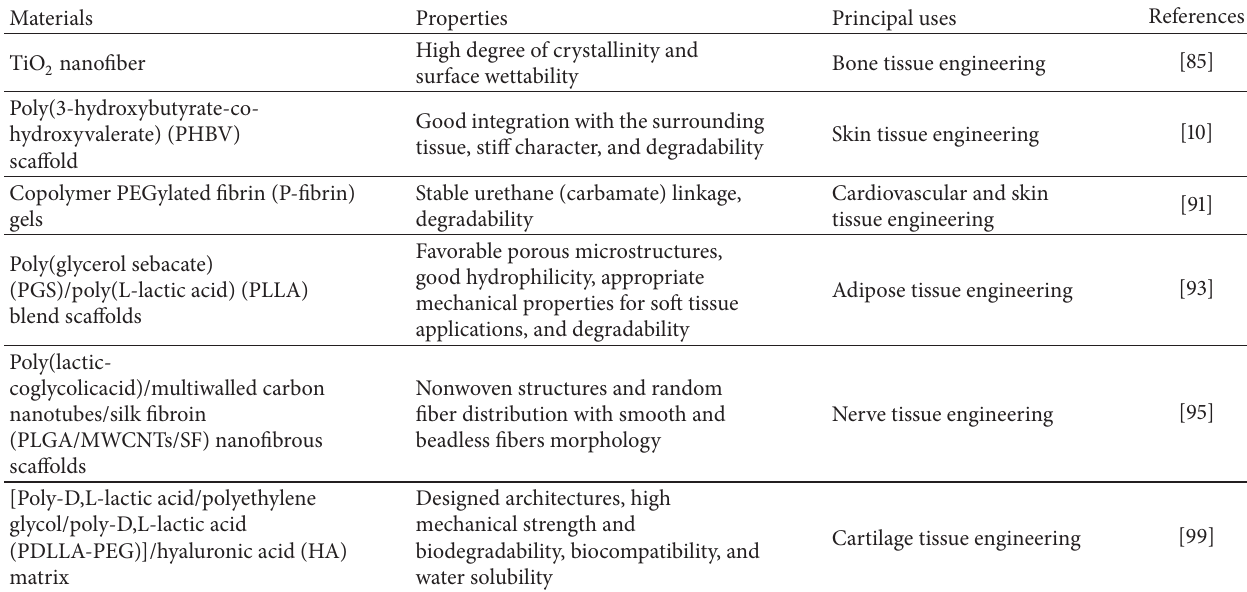
Table 1: Synthesis of synthetic materials for tissue engineering applications using